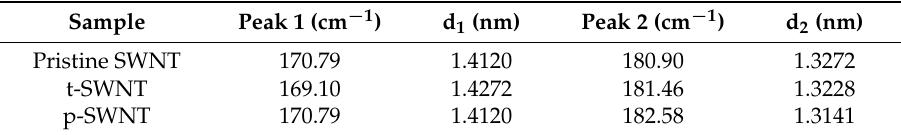
Table 2. Radial Breathing Mode (RBM) peaks of the modified SWNTs.